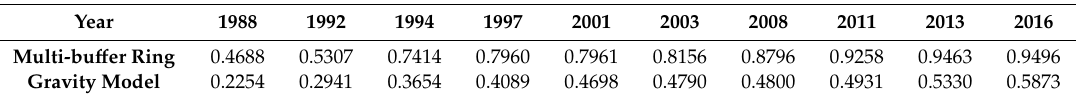
Table 4. Correlation coe ffi cients between average urban densities and mean LST derived from the multi-bu ff er ring method and gravity